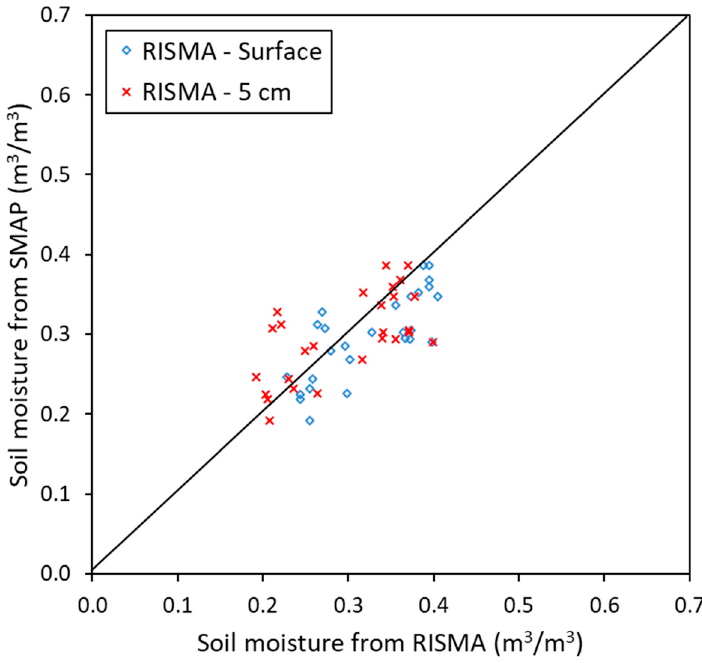
Figure 9. Comparison between the Soil Moisture Active Passive (SMAP) soil moisture values and RISMA in-situ measurements. Table 5. Estimation error statistics between SMAP soil moisture estimations and RISMA in-situ measurements and RCM CP retrievals.